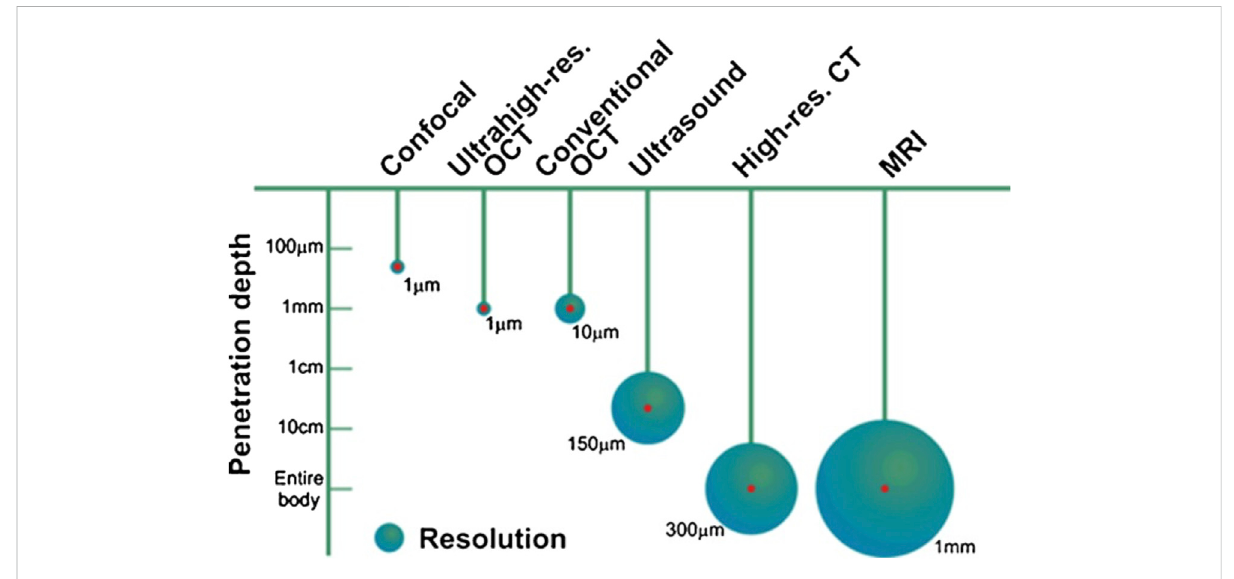
FIGURE 13 Penetration depth and resolution of different imaging modalities, reprinted with permission from (Popescu et al.,